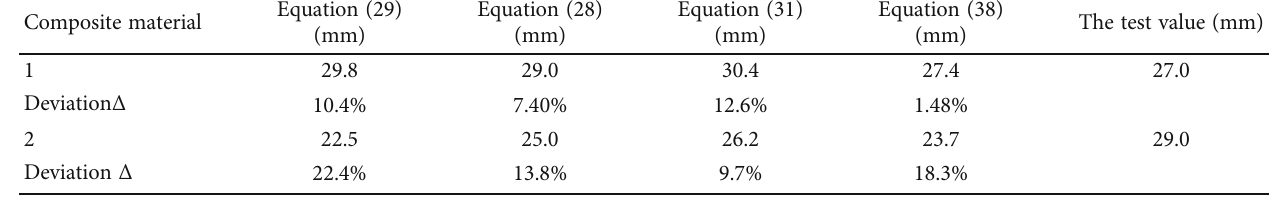
Table 5: The calculated values, the test values and deviation analysis of di ff usion radius.